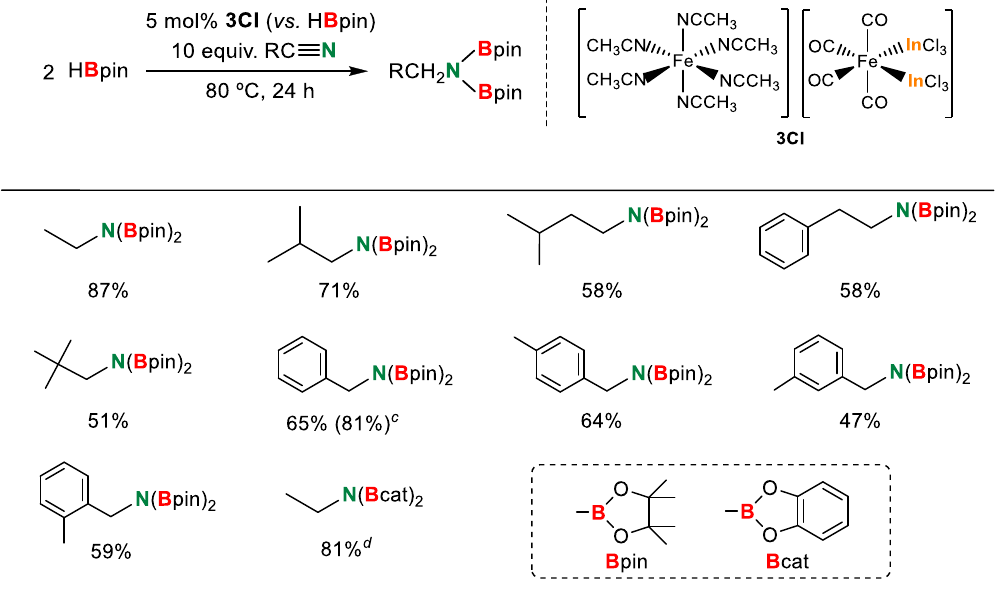
Table 9. Double hydroborylation of organonitriles in the presence of 3Cl a,b .